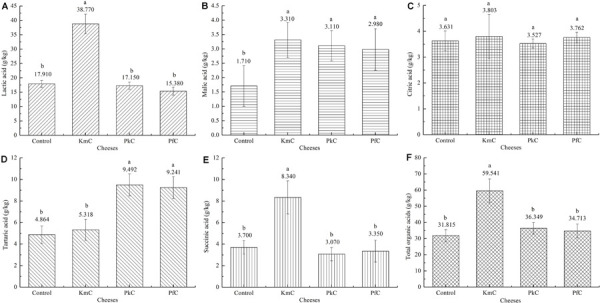
Organic acid contents in four cheeses. The letters control, KmC, PkC, and PfC represent cheeses fermented by a commercial lactic acid starter, a commercial lactic acid starter with K. marxianus A2, P. fermentans A19, and P. Kudriavzevii A11, respectively. (A–F) Represent lactic acid, malic acid, citric acid, tartaric acid, succinic acid and tatal organic acids, respectively. The letters in the column chart indicate whether the difference among data was statistically significant.